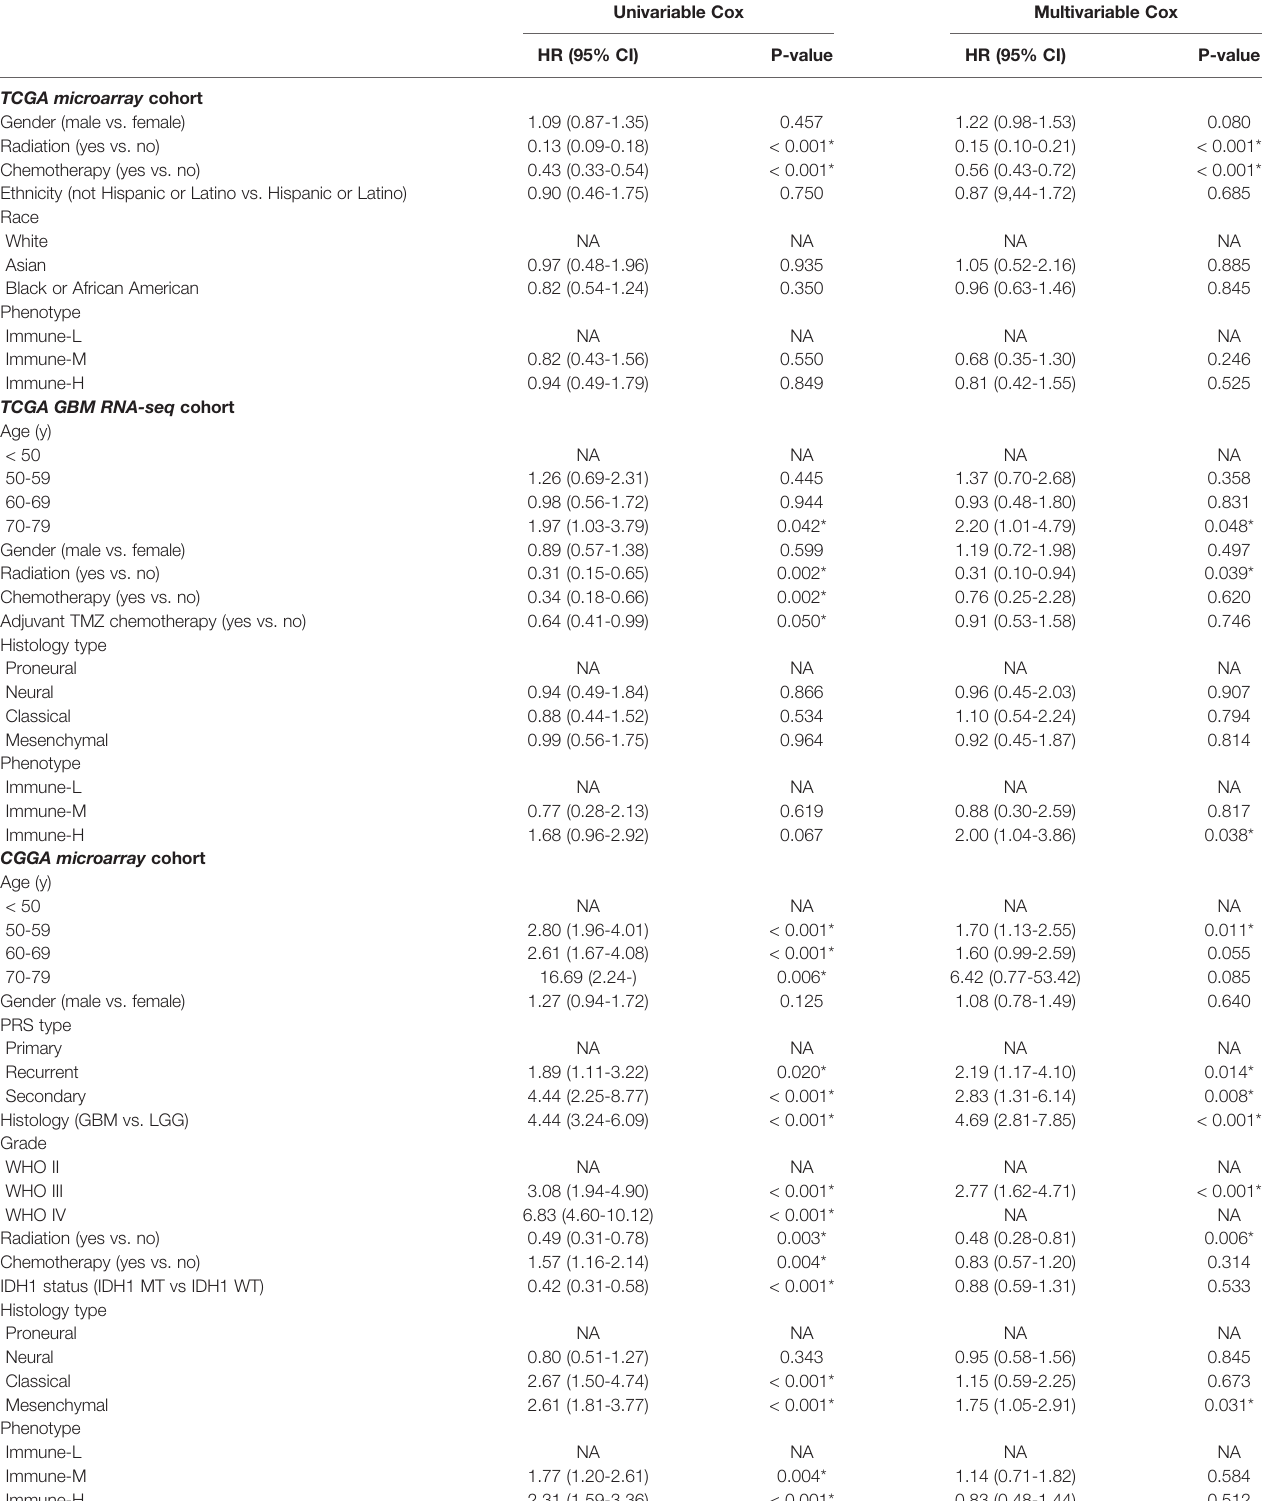
TABLE 1 | Results of univariable and multivariable analyses on overall survival of glioma patients from multiple